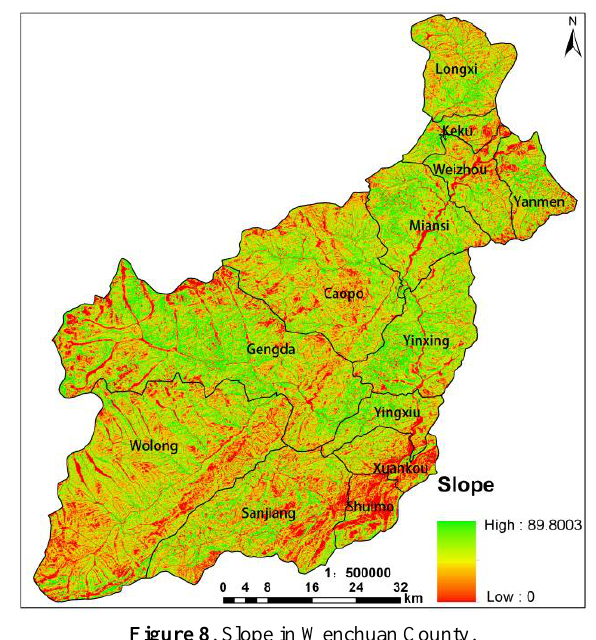
Figure 7 . Distribution diagram of emergency rescue response level in Wenchuan County.